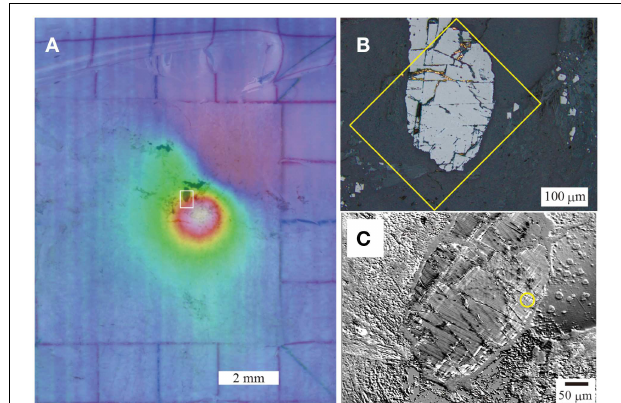
FIGURE 1 | Isothermally magnetized thin section of target magnetite obtained from Vredefort granite. (A) Microphotograph of superimposition of the thin section on a surface stray magnetic field obtained by a scanning MI magnetic microscope. Note that there are two coarse-grained magnetites beneath the magnetic anomaly. The warm color indicates a strong stray magnetic field, white the white rectangle indicates the region of the image enlarged in (B) . (B) Reflected-light optical image of the thin section. The surface was polished by ¼ - µ m diamond paste and finished by colloidal silica. The yellow rectangle indicates the area enlarged in (C) . (C) Magneto-optical Kerr-effect microscope image of target magnetite. Note the three different arrays of lamellae (white and black). The yellow circle indicates the target area analyzed by a